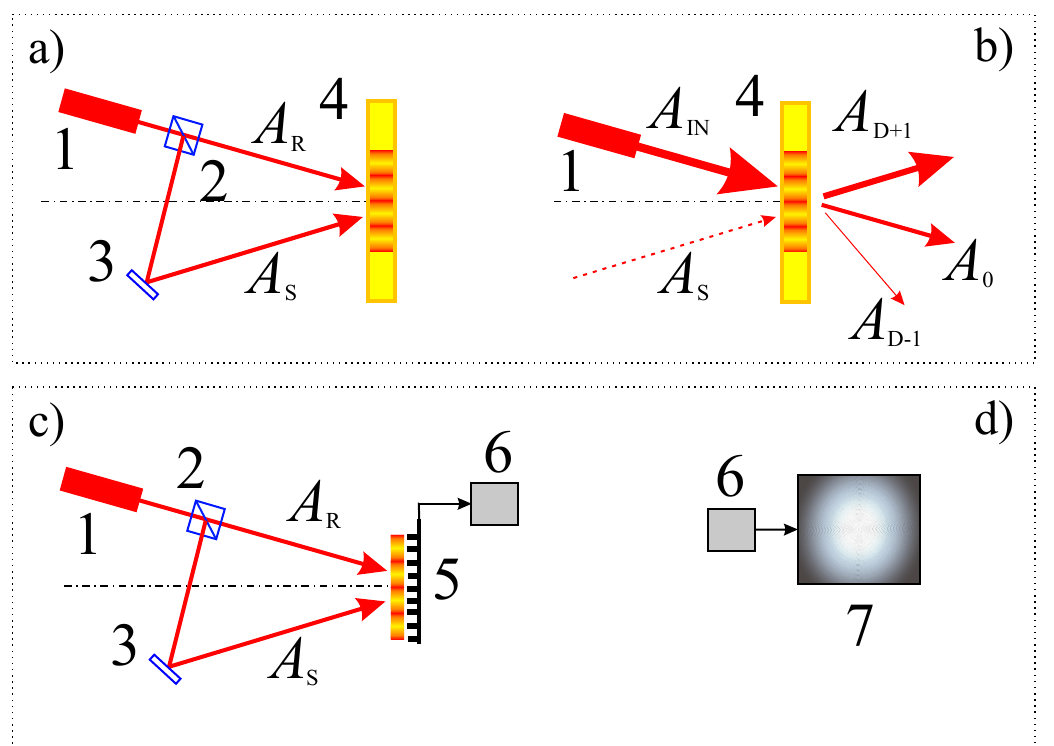
Figure 2. Recording and restoration of a hologram using a photosensitive medium: ( a , b ). Recording and digital restoration of a hologram: ( c , d ) 1—laser, 2—beamsplitter, 3—mirror (object), 4—photosensitive media (photoplate), 5—CCD camera, 6—processor, 7—monitor. A R —reference wave, A S —subjectwave, A IN —wave before separation, A 0 —zeros diffraction order, A D+1 and A D − 1 —first diffraction orders.